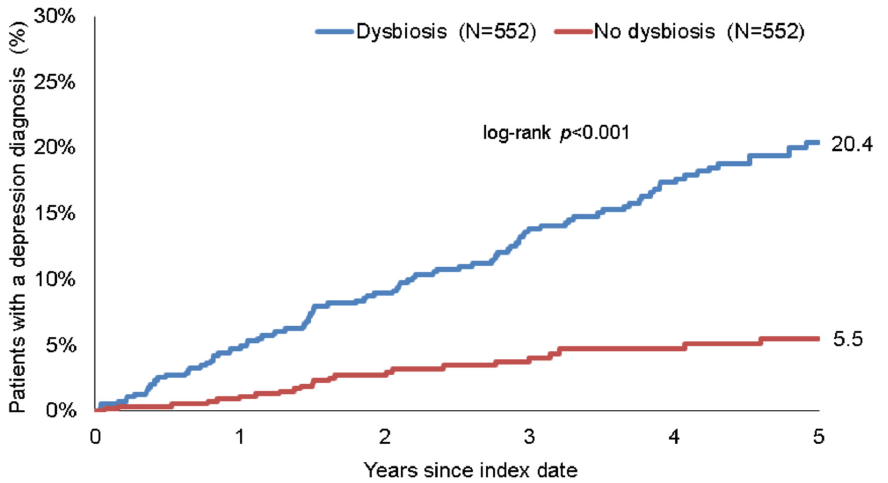
Figure 2. Kaplan–Meier curves for time to depression diagnosis in patients with and without dysbiosis.